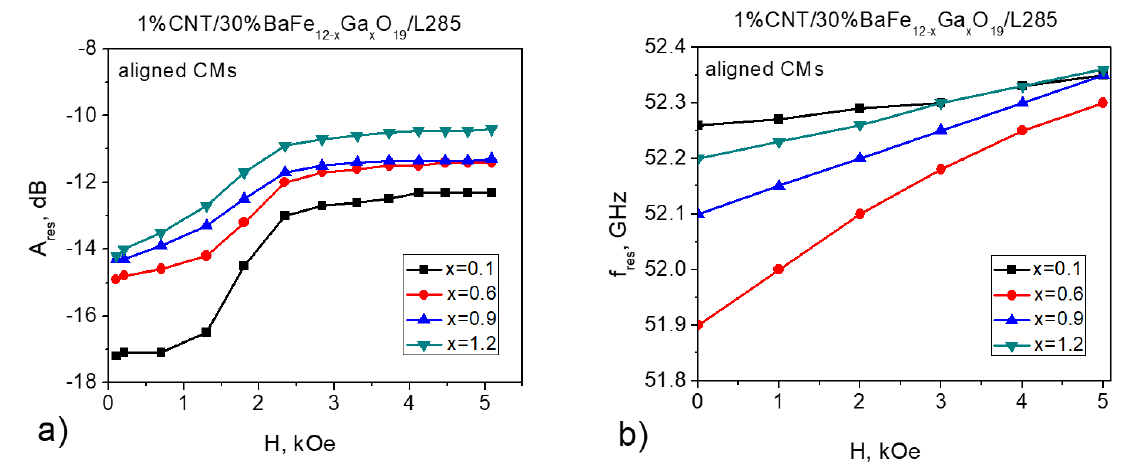
Figure 5. FMR amplitude ( a ) and frequency ( b ) as a function of the applied external magnetic field measured for aligned 1% CNT/30% BaFe 12– x Ga x O 19 /L285 composites.